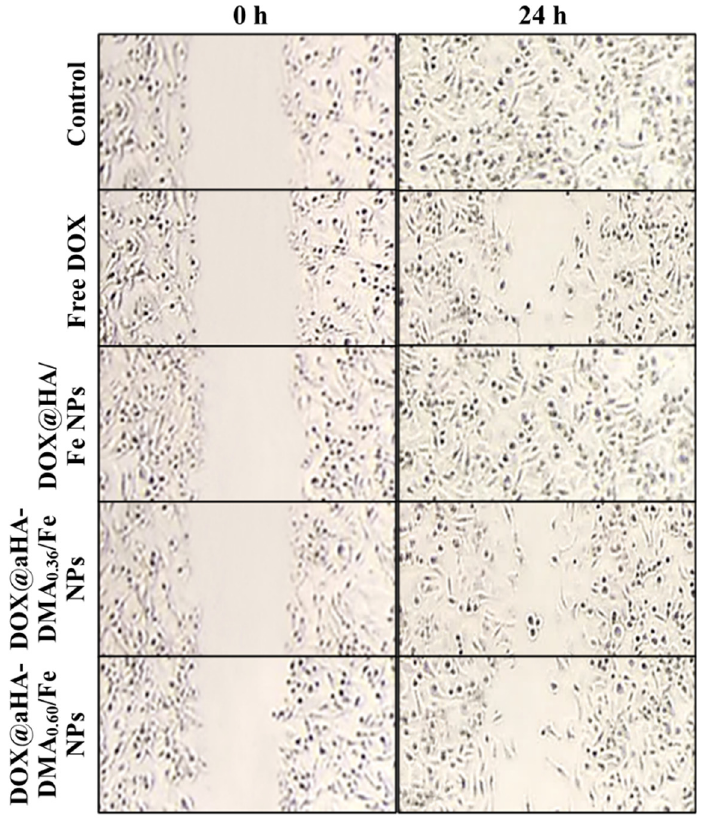
Figure 6. Local healing assays of MDA-MB-231 cells treated with free DOX (10 μ g/mL) or NPs (equivalent to DOX 10 μ g/mL) for 24 h of incubation at 37 °C.